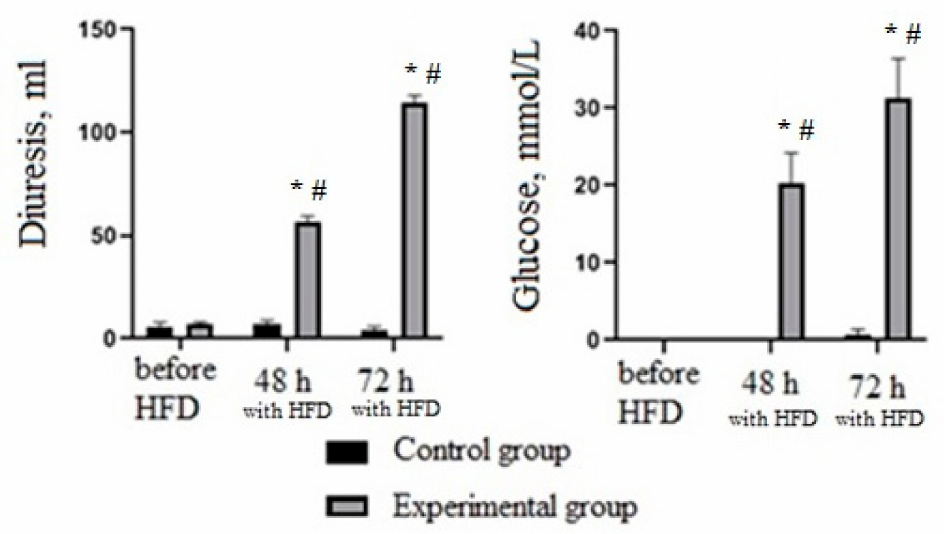
Figure 6. Changes in diuresis and urine-glucose level at 48 and 72 h after administration of STZ (35 mg/kg). * Significantly different from the period prior to administration of STZ; # significantly different from the control group.